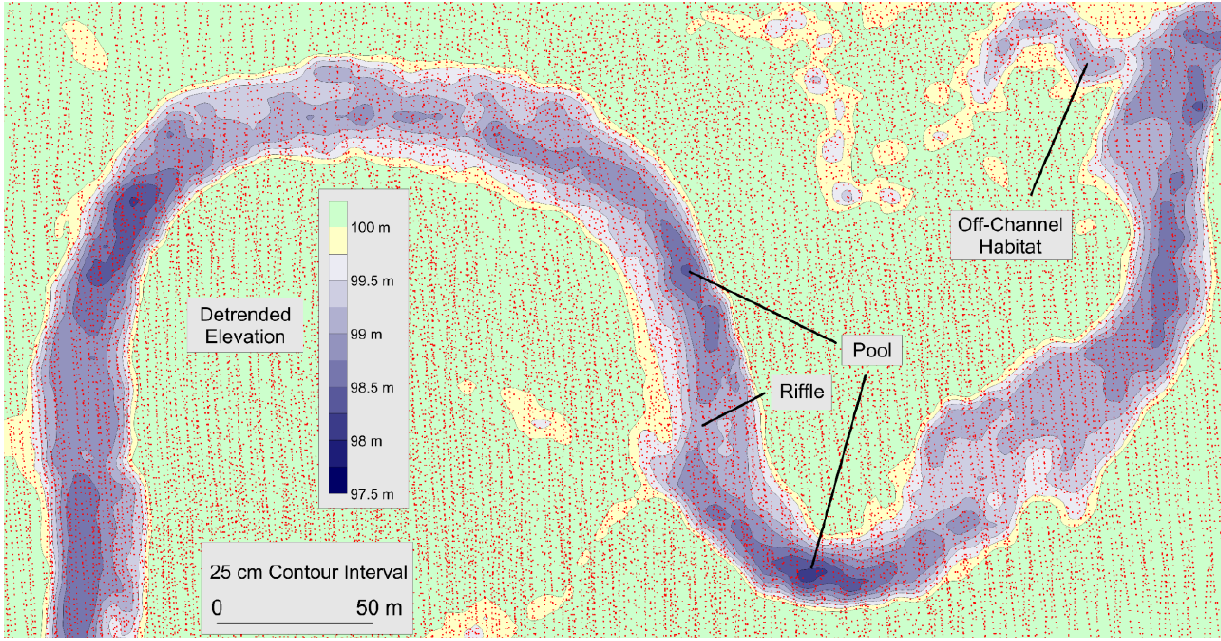
Figure 5. Typical bathymetric contours mapped by the EAARL in Bear Valley Creek, ID, USA. Red dots are measurement points made by the EAARL during multiple passes over this